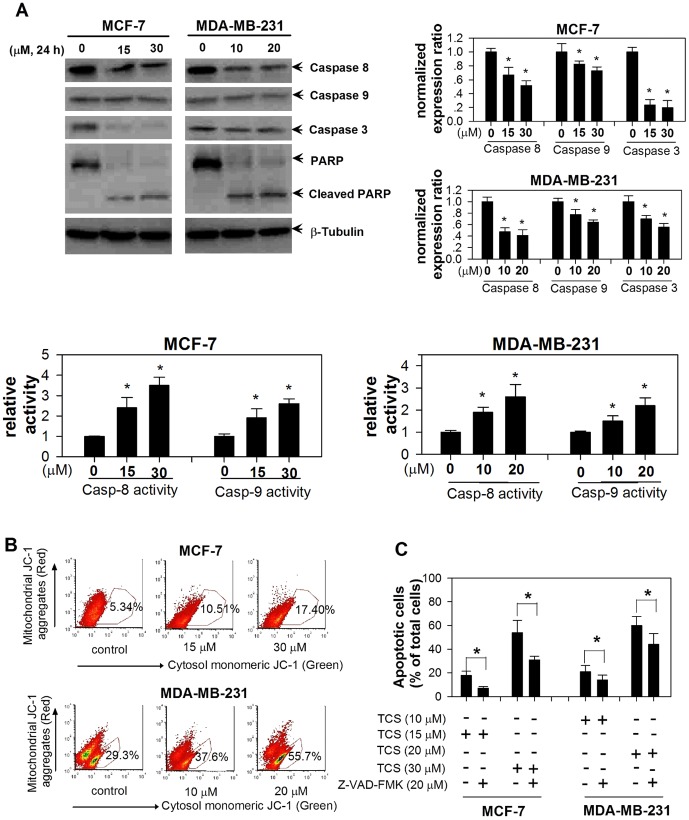
The activation of caspase cascades was involved in TCS-induced cell apoptosis.A. After treatment with TCS at the indicated concentrations, cells were harvested and protein levels of caspase-8, caspase-9, caspase-3, and PARP were determined by western blotting. Right panel, quantitative data from two independent experiments. Lower panel, The caspase-8 and caspase-9 activities were determined by ELISA kits. Asterisk, p<0.05 compared with control. B. TCS increased the number of tumor cells undergoing mitochondrial membrane depolarization. Cells were treated with TCS at the indicated concentrations for 24 h, and flow cytometry analysis of the mitochondrial membrane depolarization was carried out after JC-1 staining. C. Z-VAD-FMK pretreatment retarded TCS-induced cell apoptosis. After different treatments as indicated at the bottom of the histogram, cells were harvested, stained with Annexin V-PI, and processed for flow cytometry. Asterisk, p<0.05 compared with control.